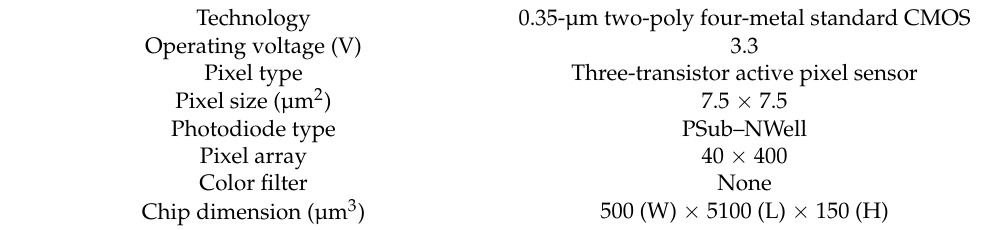
Table 1. Specifications of the needle-type CMOS image